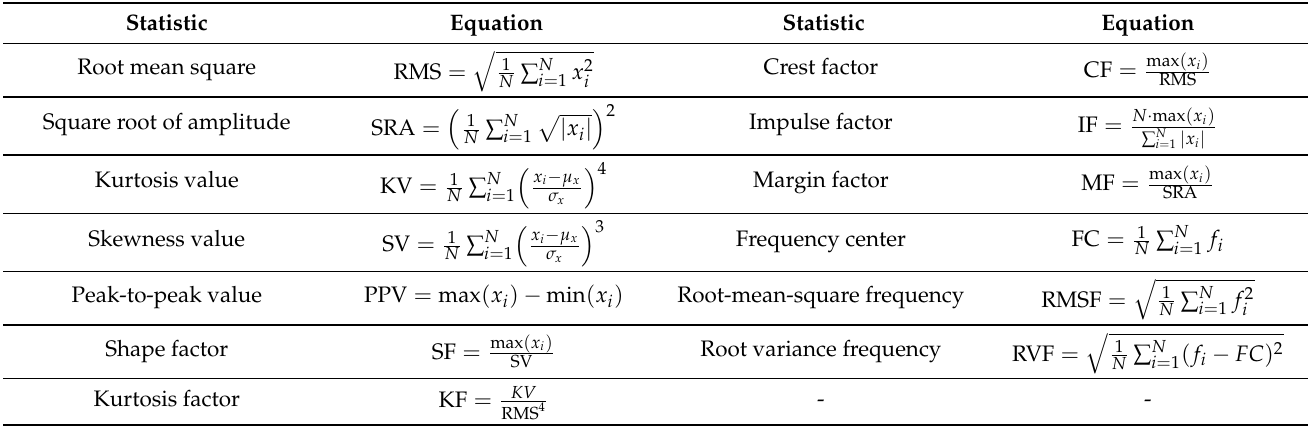
Table 5. Extracted features [49].